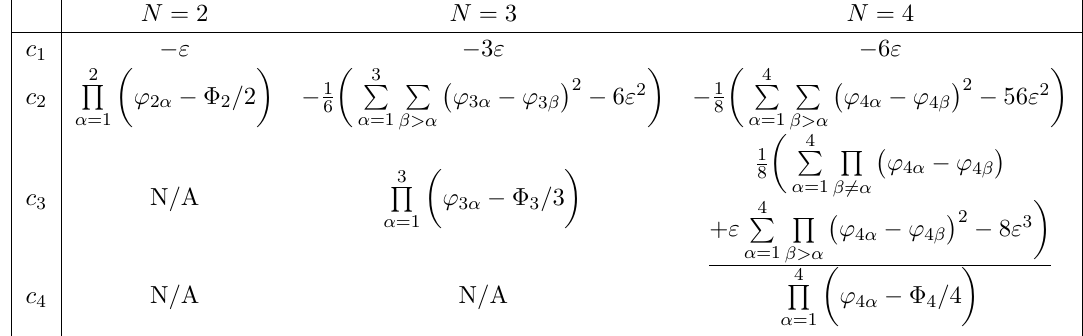
Table 2 . Coe(cid:14)cients of (Capelli corrected) characteristic equation for the SL( N; C ) moment maps, for N = 2 ; 3 ; 4, in terms the scalars ’ N(cid:11) on the central node. Keeping with the notation of the main text, (cid:8) N is the sum of the ’ N(cid:11)